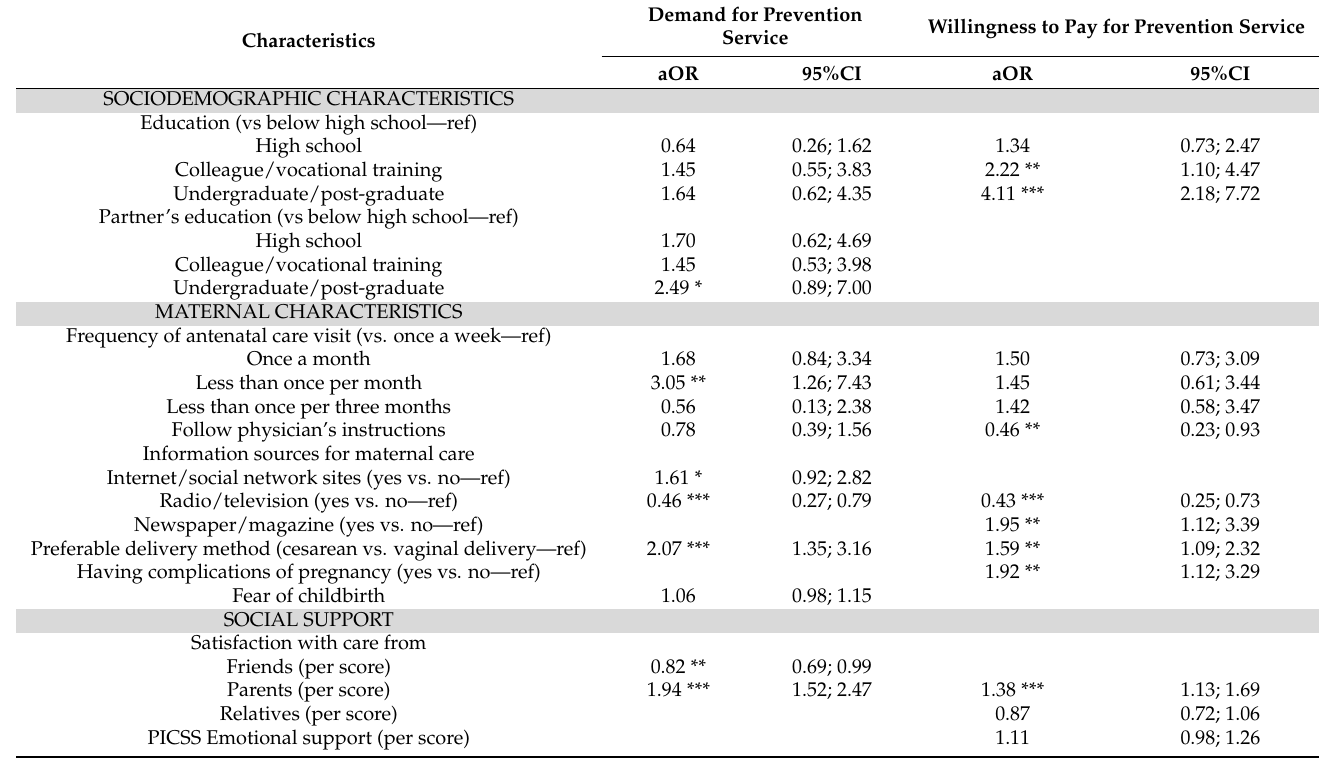
Table 5. Factors associated with demand and willingness to pay for fear-prevention